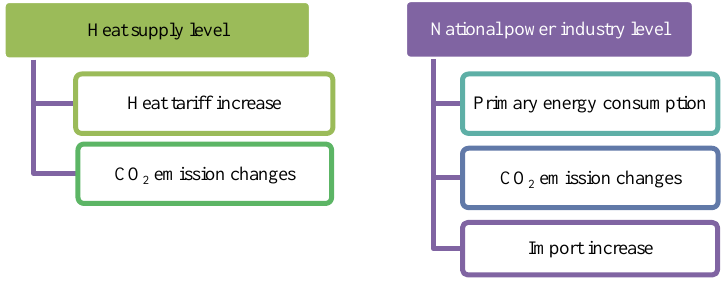
Fig. 11. Influence evaluation levels in case of MPC